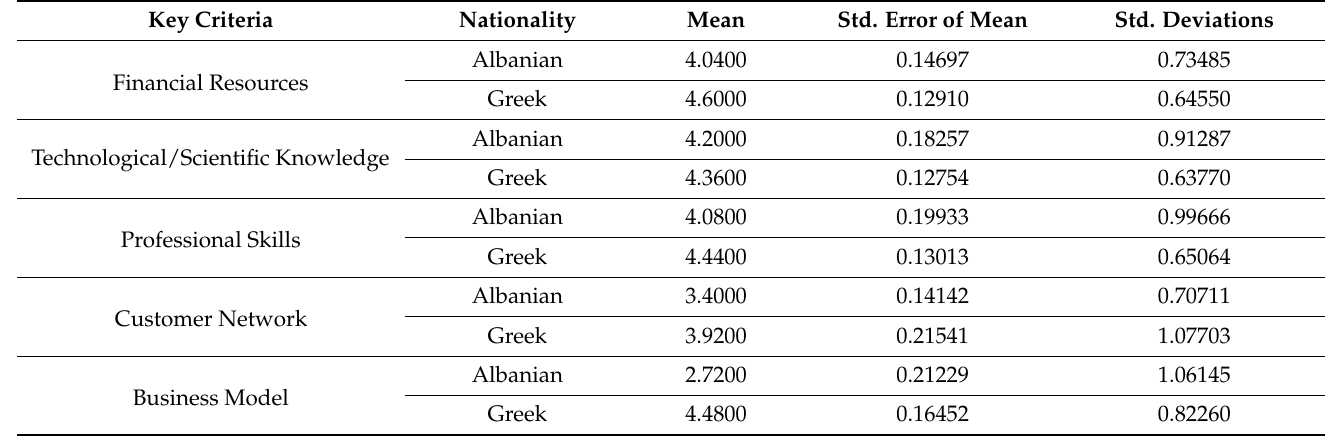
Table 4. Means, standard error of means, and standard deviations.